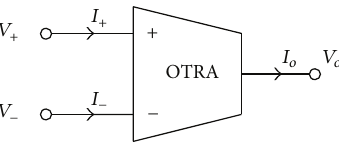
Figure 1: OTRA circuit